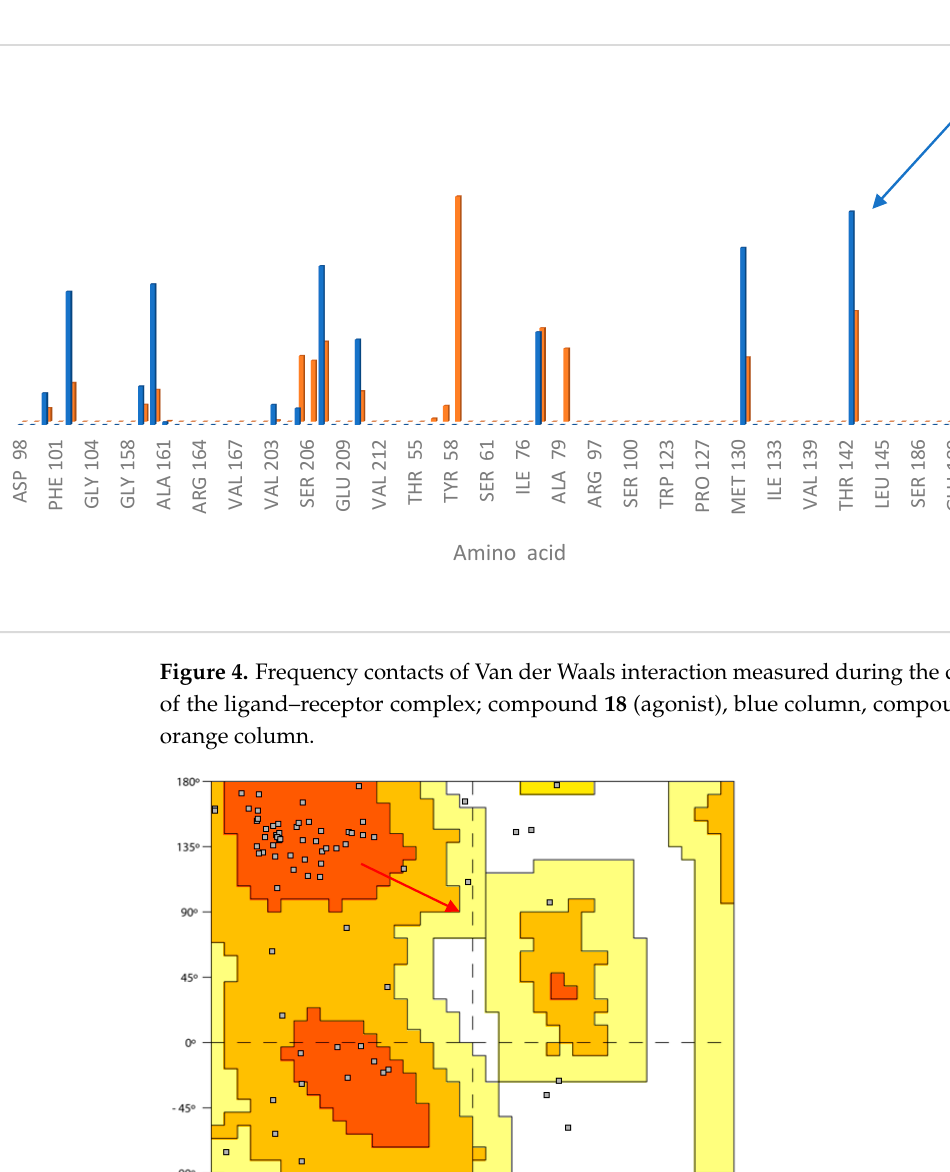
Figure 5. Ramachandran plot of the protein-ligand complex conformation at the end of 60 ns.